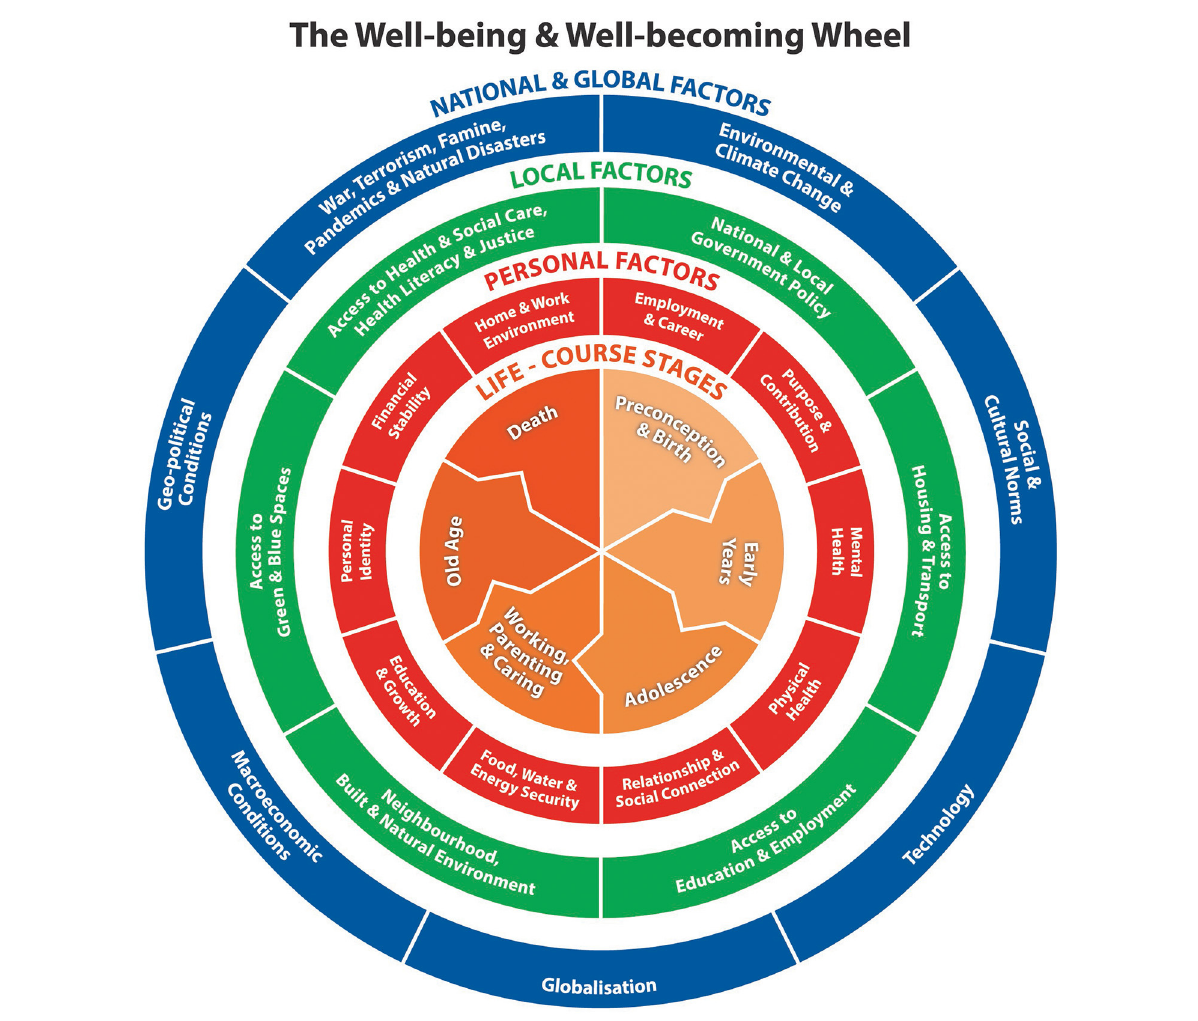
FIGURE1 The well-being and well-becoming